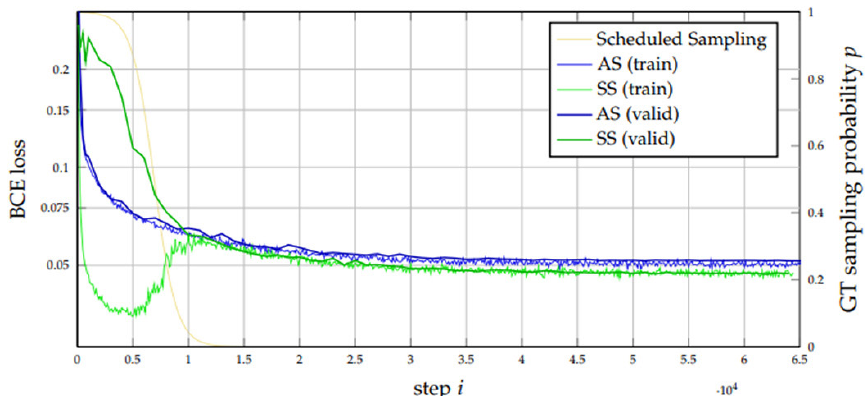
Fig. 8. Influences of scheduled sampling regarding the training and validation error in the context of recurrent networks and future frames prediction on moving